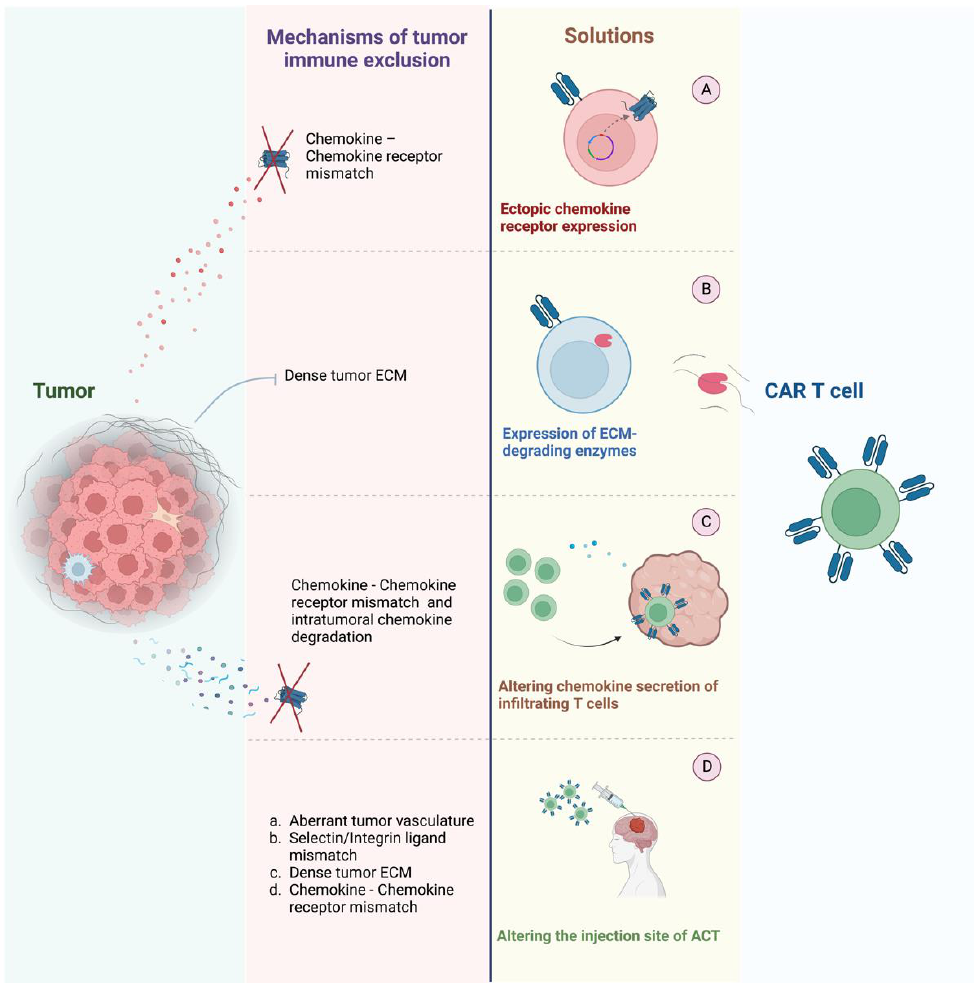
Figure 2. Immune exclusion mechanism by tumors and means of engineering ACT to overcome those exclusion mechanisms. Most engineering methods of ACT target the chemokine–chemokine receptor axis, with only a small proportion of trials targeting other exclusion mechanisms by tumors: (A) Ectopic chemokine receptor expression on CAR T cells can aid to overcome a chemokine–chemokine receptor mismatch. (B) ECM-degrading enzymes aid CAR T cells in infiltrating densely packed tumor beds. (C) Altering chemokine secretion of infiltrating T cells helps recruit more anti-tumor immune cells and subsequent CAR T cells. (D) Tailoring ACT delivery to the tumor site mitigates challenges posed while infiltrating into tumors. Figure created with BioRender.com.